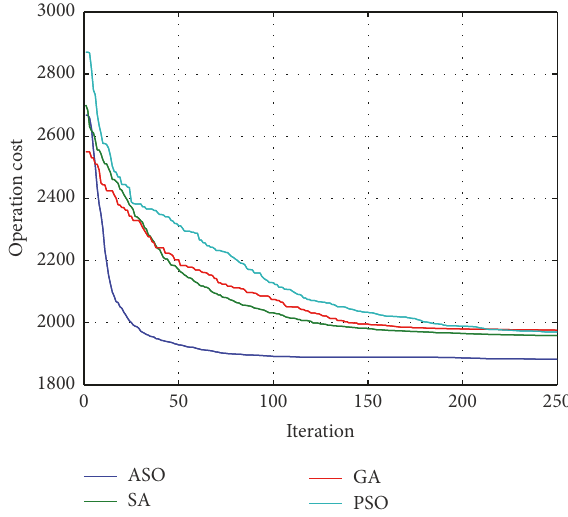
Figure 9: Convergence graph of ASO, SA, GA, and PSO for Case 2.